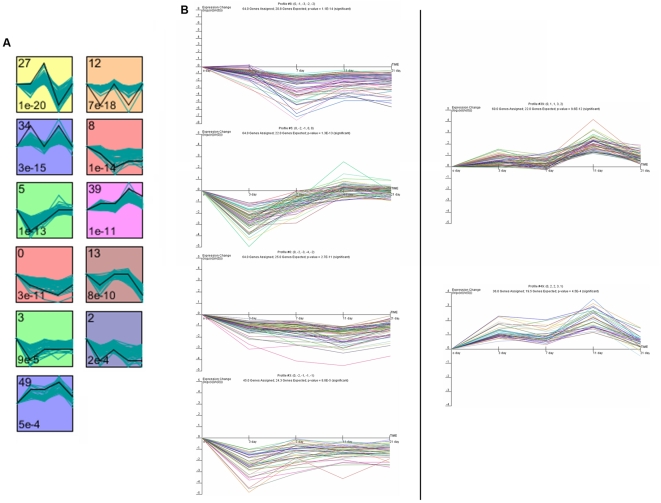
STEM clustering analysis of 1302 significant differential genes in BM after IR.(A) Eleven profiles (p<0.001) with a statistically significant number of genes assigned. The number in the top left corner represents the ID of the profile; the bottom left corner shows p-value and the green curve shows individual gene expression profiles. (B) Six model profiles detailed in expression graphs. The above images are considered to be the potential main expression profiles in our experiment, with the tendencies consistent with or opposite to that of a myelosuppression change curve (Figure 1). Details of the genes that mapped to each temporal profile are found in Table S2.